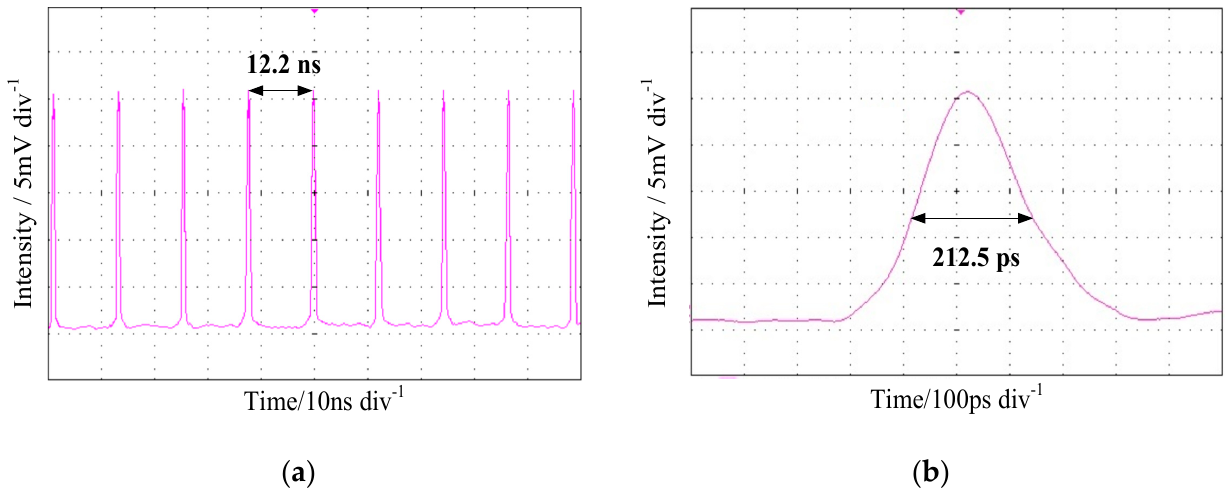
Figure 3. Pulse trains wave-form of the CWML Er 3+ -doped fiber laser: ( a ) pulse trains; ( b ) wave-form of single CWML pulse. The mechanical extrusion structure presses a piece of passive fiber in the